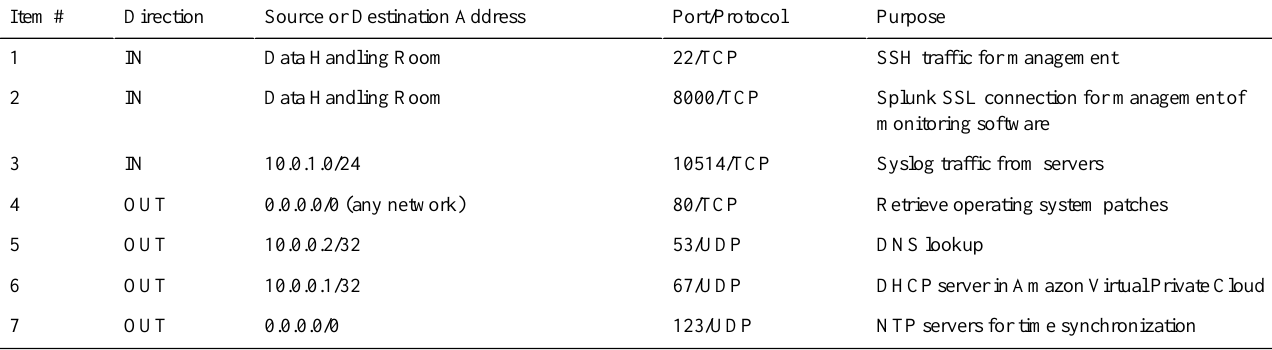
Table 1. Audit network security group rules. a